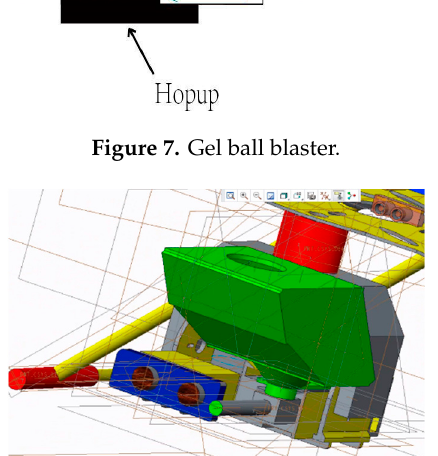
Figure 8. Assembly drawing of continuous gel balls feeding device.